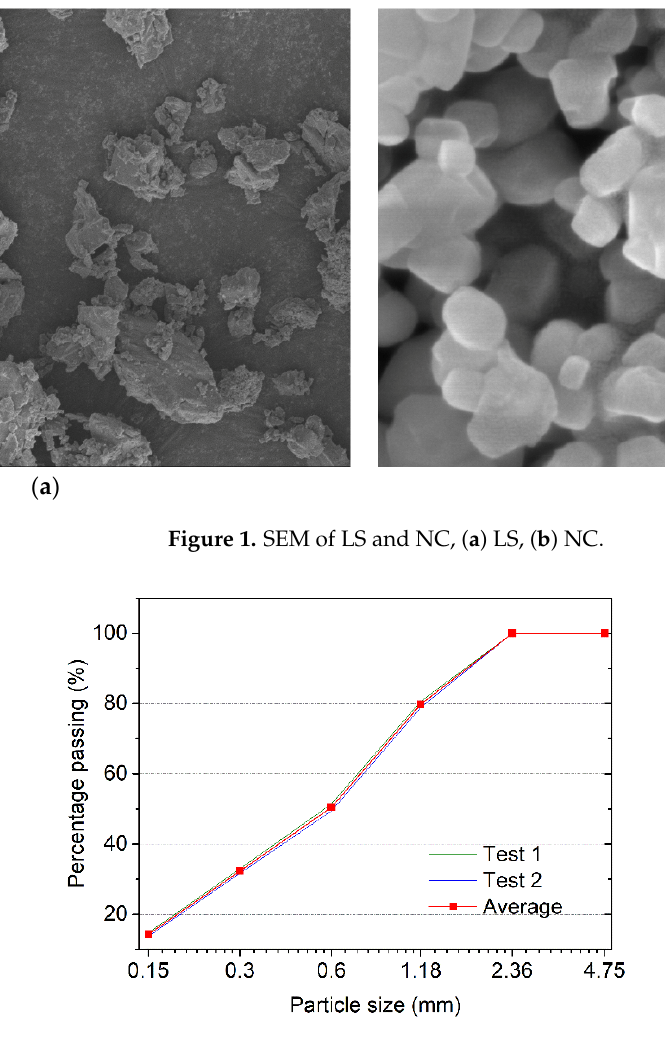
Figure 2. Particle size distribution of quartz sand.